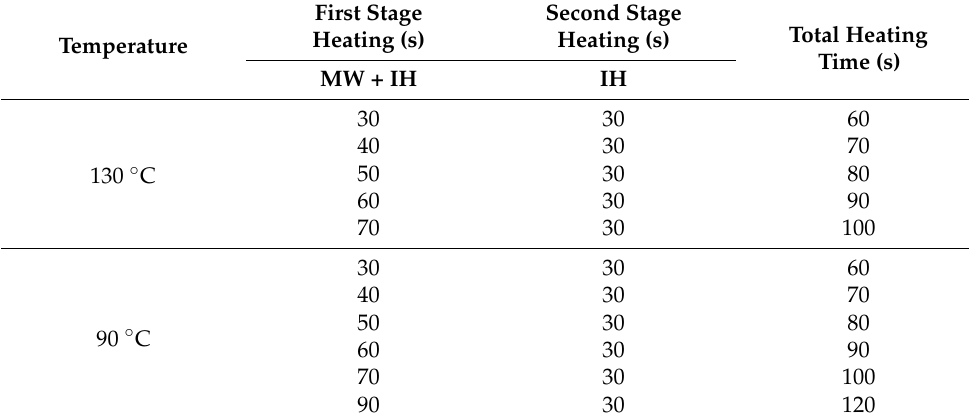
Table 1. Heating conditions of MAIH system for white shrimp cooking. First Temperature